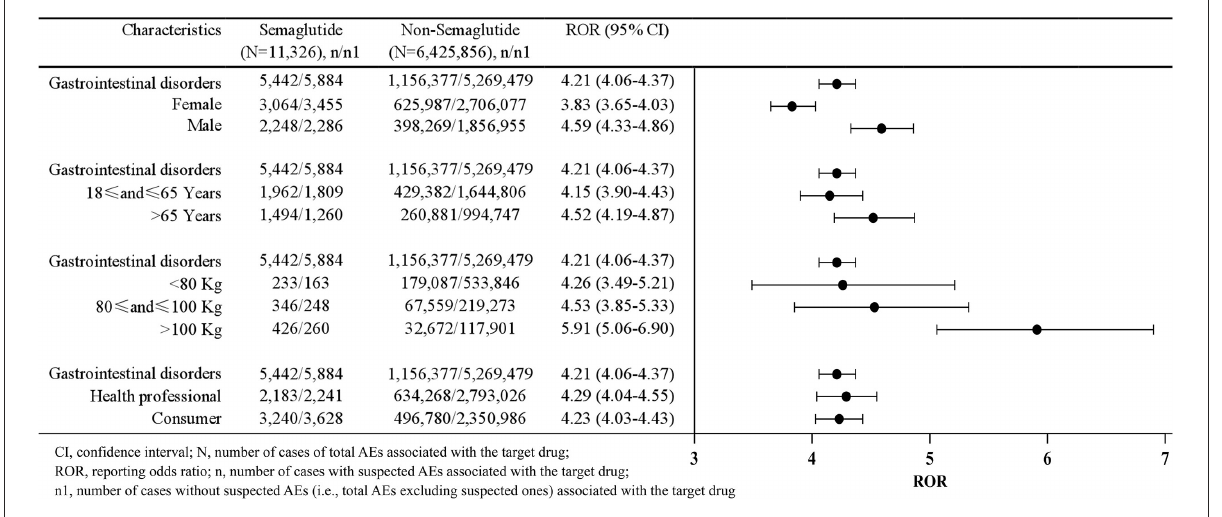
FIGURE3 Stratification analysis of semaglutide-induced gastrointestinal